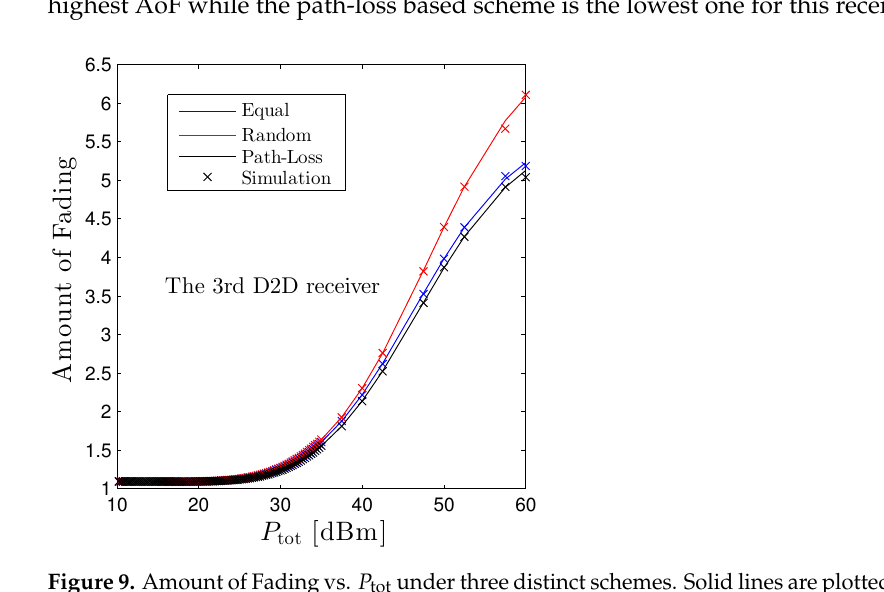
Figure 9. Amount of Fading vs. P tot under three distinct schemes. Solid lines are plotted by employing (17) and markers are Monte Carlo simulation.